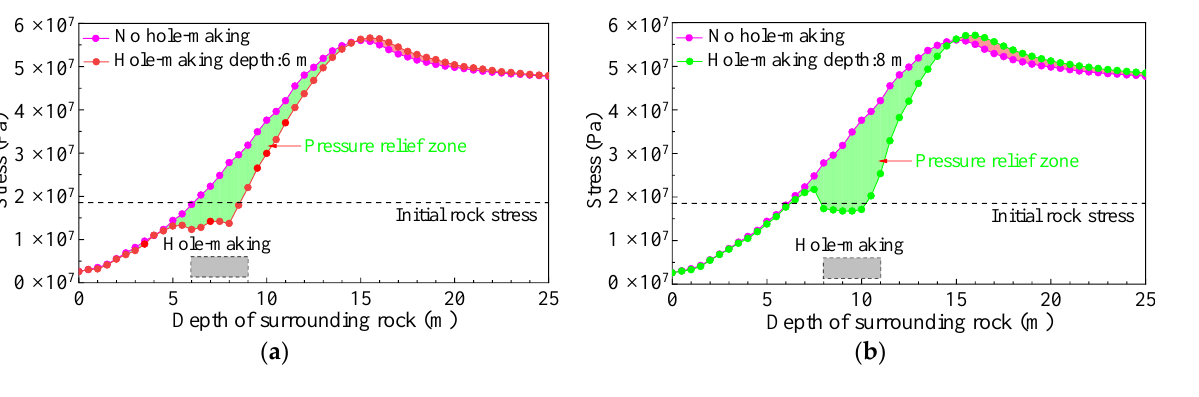
Figure 16. Comparison of stress curves of the roadway rib at different hole-making depths in the mining influence stage. ( a ) Hole-making depth = 6 m; ( b ) Hole-making depth = 8 m.